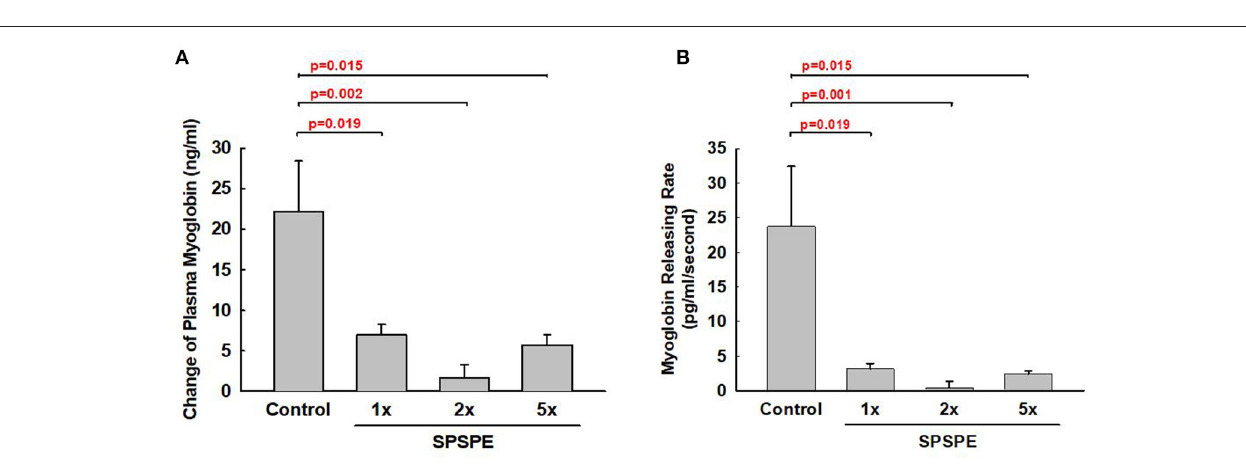
FIGURE 6 | The effects of SPSPE treatment for 33 days on the plasma level of myoglobin (A) and myoglobin releasing rate (B) after an exhaustive swimming exercise test, each value represents Mean ± SEM, n = 9. objective lens 20 times), we found that the liver plates arranged in a radial pattern in the control and SPSPE treated